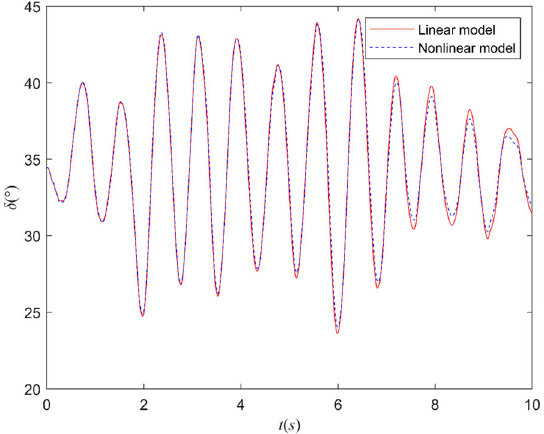
Fig. 4 Comparison of power angle curves between linear and nonlinear models of the system( σ = 0.05)